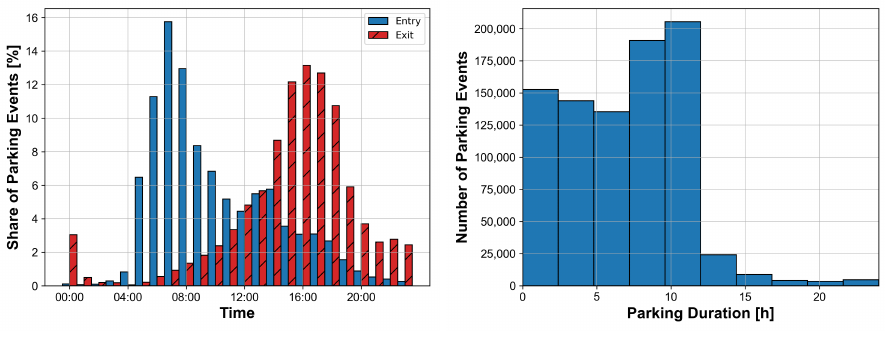
Figure 3. Parking Behavior of